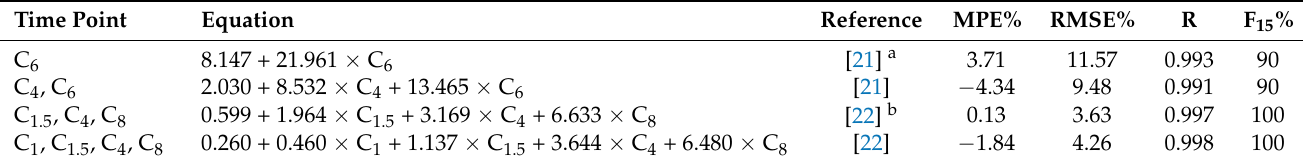
MPE, mean prediction error; RMSE, root mean squared prediction error; R, the Pearson correlation coefficient between AUC pred and AUC obs ; F 15 , the percentage of prediction error falling within the ± 15%. a Prediction of AUC ss,24h . b Prediction of AUC ss,12h